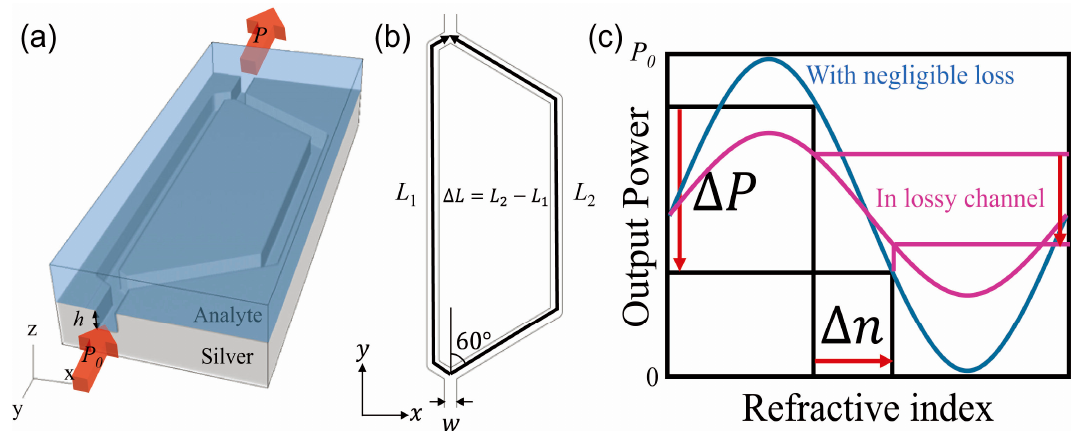
Figure 1. ( a ) A schematic diagram of the proposed MZI index sensor. The channel waveguide on the silver substrate splits into two pathways with different path lengths and combines again at the exit. An analyte with a refractive index of n is filled in the waveguide. The input and output power are represented by P 0 and P , respectively; ( b ) A top view of the plasmonic channel waveguide MZI. The two waveguides have path lengths of L 1 and L 2 ( L 2 > L 1 ), while having the same width of w . The length difference is expressed by Δ L . All corner angles are set to 60 degrees; ( c ) a conceptual figure of the output power of MZI modulation as a function of the refractive index of the analyte. Δ n denotes the refractive index change and Δ P is the corresponding power modulation.